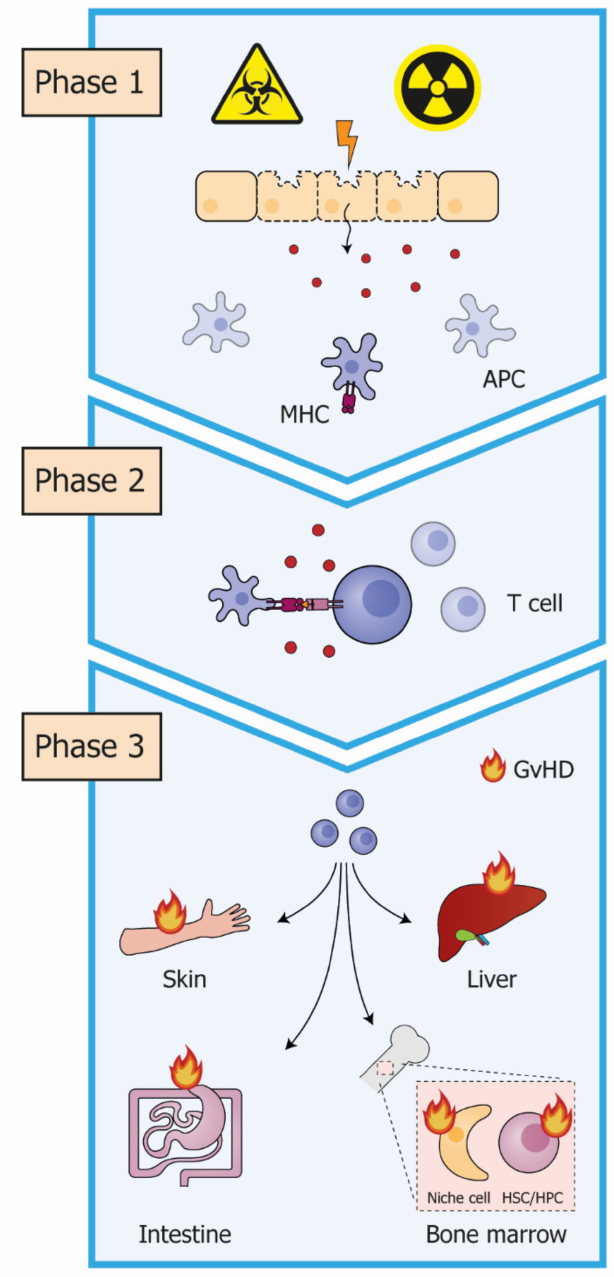
Figure 1. The three phases in GvHD pathogenesis. Phase 1 : Chemotherapy and/or radiotherapy, given as part of the pre-transplantation conditioning regimen, induce widespread tissue damage. As a result, host antigen presenting cells (APCs) become activated. Activated APCs secrete